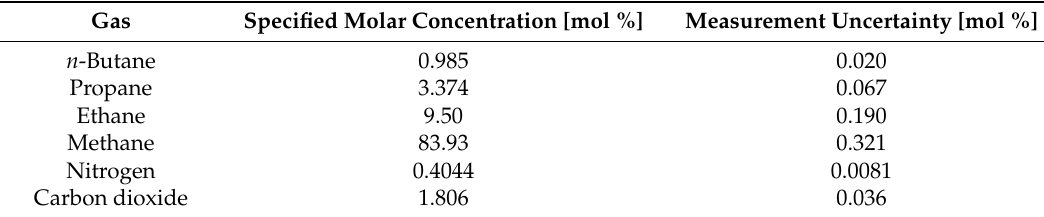
Table 1. Composition of the gas mixture used in the experiments according to the manufacturer certificate. Gas Specified Molar Concentration [mol %] Measurement Uncertainty [mol %] n -Butane 0.985 0.020 Propane 3.374 0.067 Ethane 9.50 0.190 Methane 83.93 0.321 Nitrogen 0.4044 0.0081 Carbon dioxide 1.806